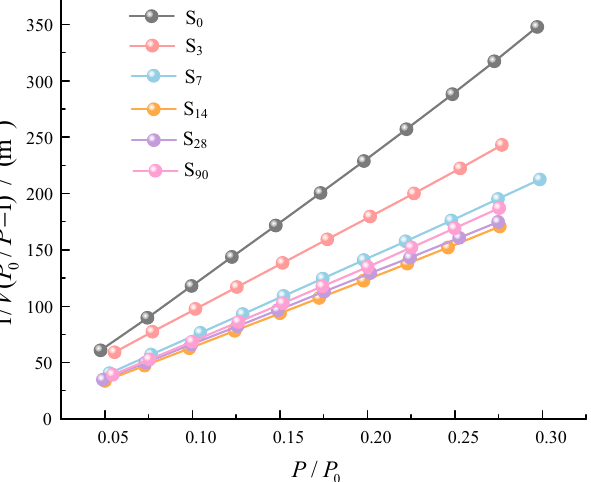
Figure 8. BET (Brunauer − Emmett − Teller) curves of the solidified/stabilized gold tailings after different six curing periods (0 to 90 d).